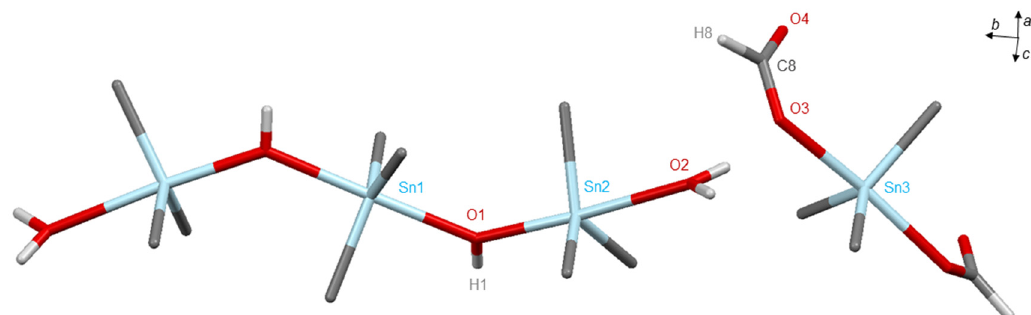
Figure 15. Molecular structure of 12 , adapted from [66] (MERCURY view). Hydrogen atoms of methyl groups are omitted for clarity (Sn light blue, O red, C grey, H white).